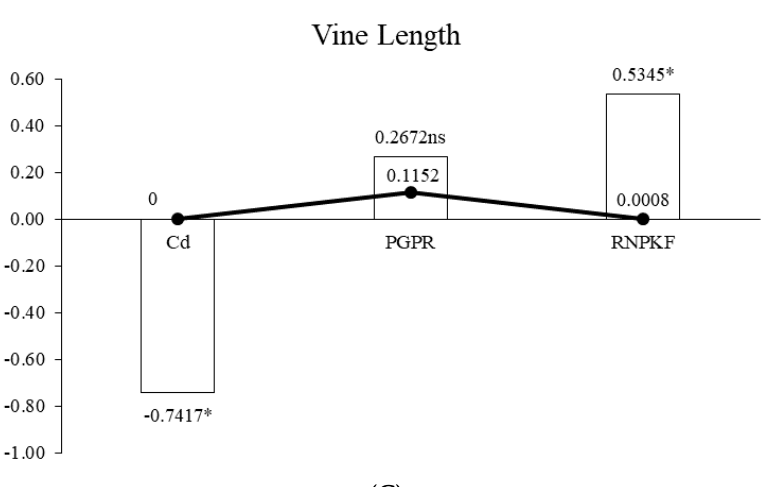
Figure 1. Effect of rhizobacteria with and without recommended NPK fertilizer on vine length (VL) of bitter gourd under Cd ( A ). Interaction graph of PGPR (NS1 = S. maltophilia , NS2 = A. fabrum ), recommended NPK fertilizer (RNPKF) and Cd levels for vine length (cm) ( B ). Pearson correlation of vine length with different levels of Cd, ACC deaminase (ACCD) PGPR and recommended NPK fertilizer where the y -axis represents the values of correlation (bars in the graph) and x -axis probability (lines in the graph) ( C ). * = p ≤ 0.05; ns = p > 0.05 non-significant.